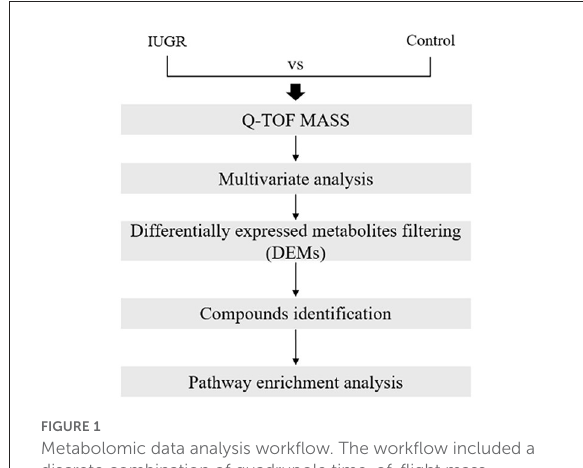
FIGURE1 Metabolomic data analysis workflow. The workflow included a discrete combination of quadrupole time-of-flight mass spectrometry, multivariate statistics, multivariate machine learning, filtering of differentially expressed metabolites, compound identification, and pathway enrichment